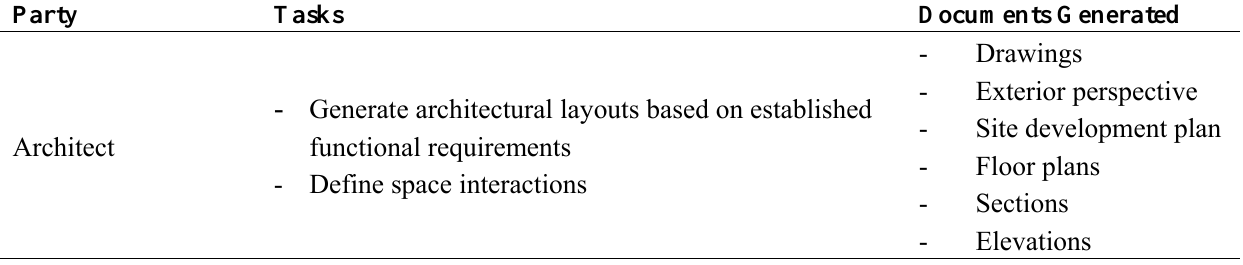
Table 2. Examples of tasks for a set of parties involved in advanced energy retrofit projects and example set of documents they generate (a sample generated from Lee et al.